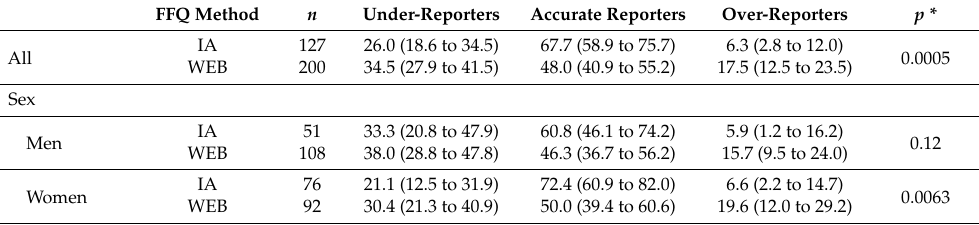
Table 3. Prevalence of under- and over-reporting of energy intake according to agreement with measured energy requirements 1